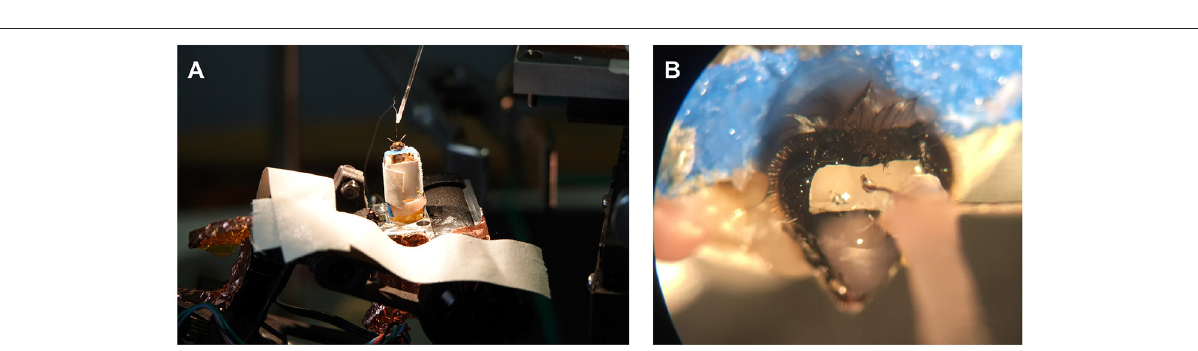
FIGURE 5 | Preparation setup and recording site. (A) Preparations for electrophysiological experiments were performed in a controlled environment with the honey bee already attached to the quadcopter. (B) A small rectangular incision into the head capsule revealed the bee brain’s alpha lobe after the trachea and glands were pushed aside. The electrode bundle visible in the microscope was attached to a micromanipulator with dental wax. Once the electrode bundle was implanted, it was connected to the head stage on the copter via a custom connector jack. Finally, the electrodes and incision were sealed with silicone. Before the animal was moved to the field, the electrode holder was detached to allow for a free anterior